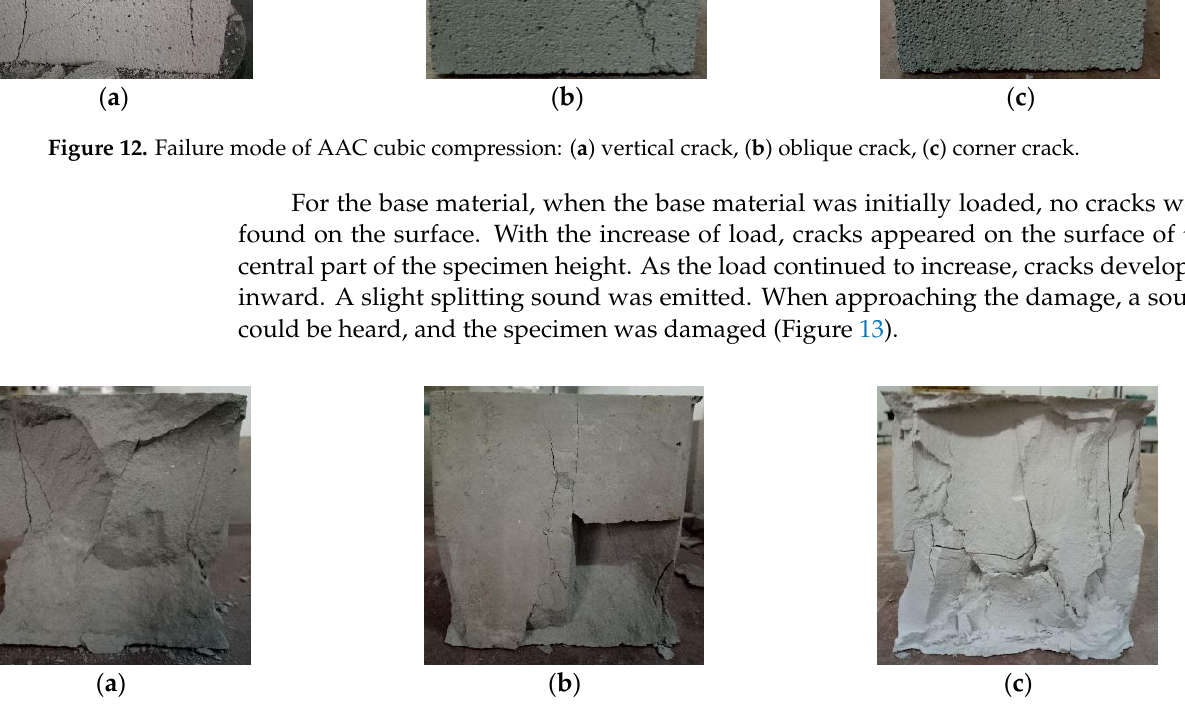
Figure 13. Failure mode of base material cubic compression: ( a ) “X” type crack, ( b ) corner crack, ( c ) irregular crack.